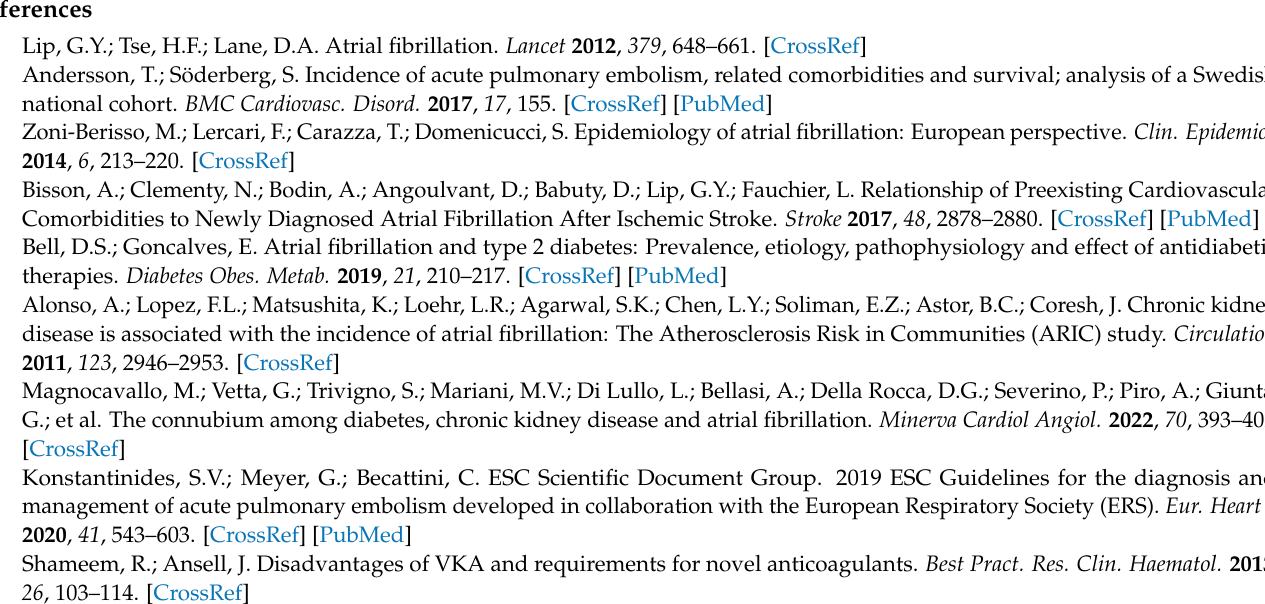
Pharmacovigilance Network: definitions of adverse reaction and serious adverse drug reaction. Table S2. Definitions used to search for intracranial hemorrhage (ICH) adverse drug reactions. Table S3. Definitions used to search for gastrointestinal (GI) adverse drug reactions. Table S4. How to search for adverse drug reactions